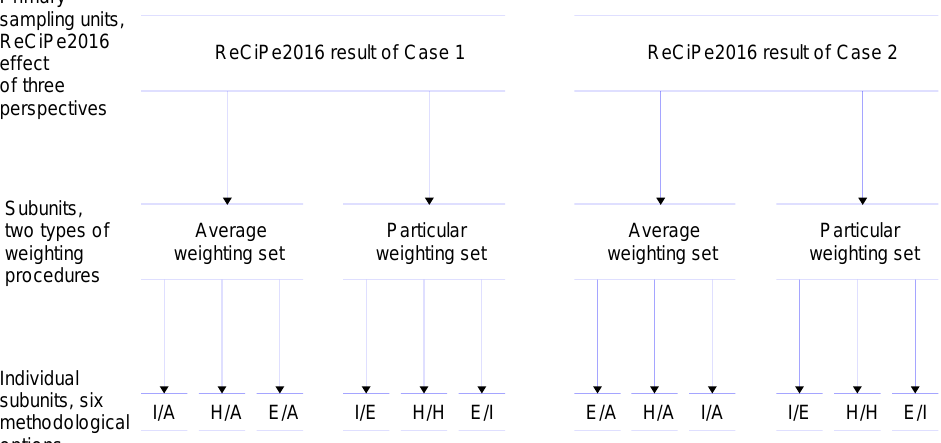
Figure 5. Two-stage analysis of variance (ANOVA) hierarchical design structure for environmental evaluation of Case 1 and Case 2 (ReCiPe 2016 single-score evaluation).